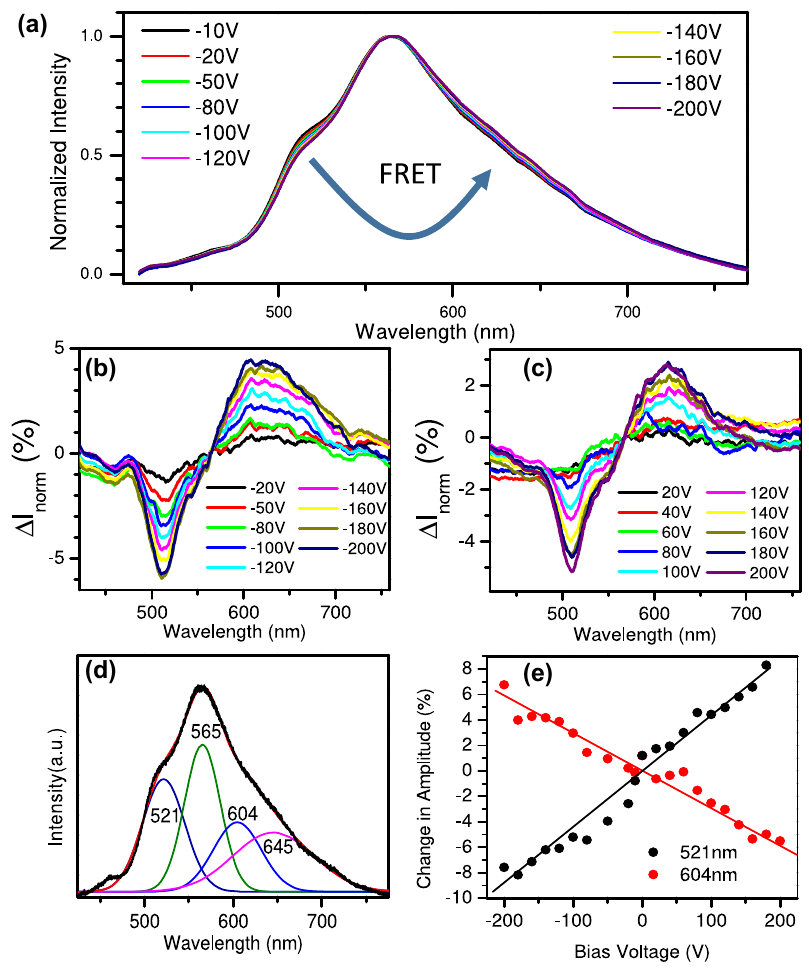
Figure 2: Excitation (dashed lines) and emission spectra (solid lines) of fluorescein (a) and R6G (b) deposited on SiO (red lines), respectively, at the same thickness of the and SLG/SiO 2 dye film (10 nm). Detection wavelengths for excitations spectra 560 nm/650 nm and excitation wavelengths for emission spectra 405 nm/430 nm for fluorescein/R6G, respectively.